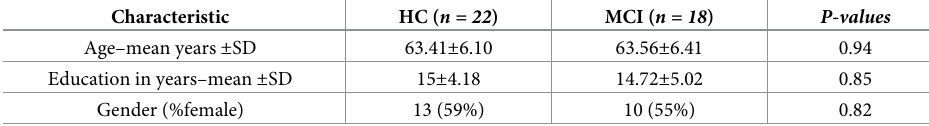
Table 1. Demographic information of